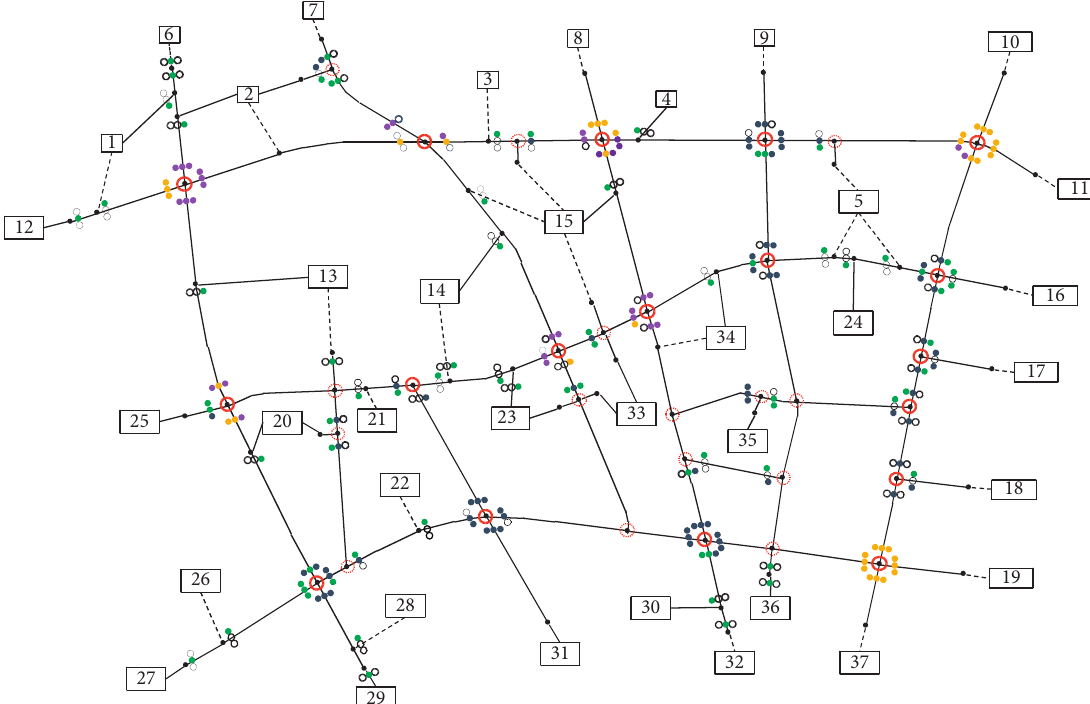
Figure 7: The distribution of optimally selected virtual AVI points.